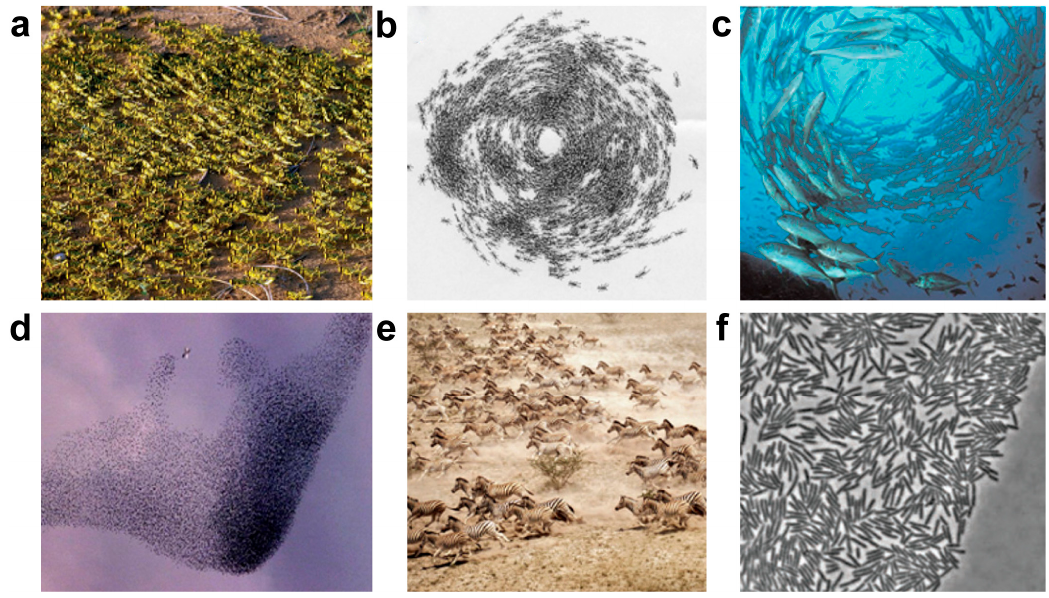
Figure 1. Collective behavior in nature. ( a ) Locusts marching. ( b ) Colony of army ants. ( c ) Fish vortices. ( d ) Thousands of birds producing a fascinating display. ( e ) A herd of zebra. ( a – d reproduced from [2]) ( f ) Swarming of Escherichia coli (reproduced from [37]).